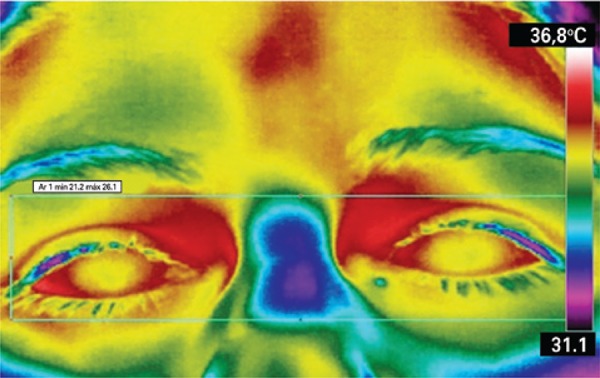
Imagem ocular para obtenção da temperatura máxima da região ocular e mensuração indireta da temperatura central por termografia